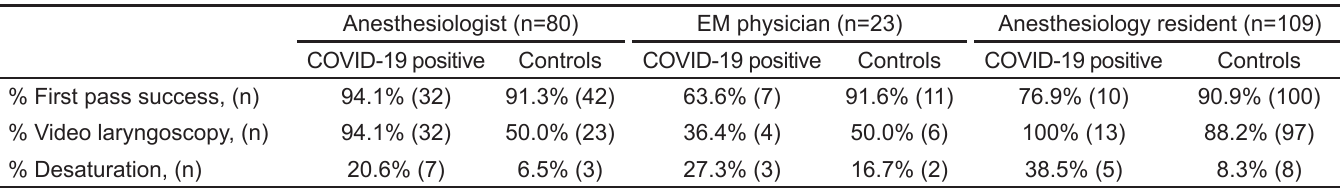
Table 5. Subgroup analysis of first-pass success rate and video laryngoscopy use by provider type and COVID-19 status.